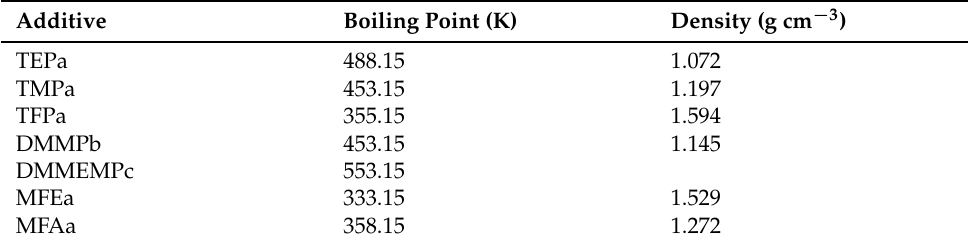
Table 17. Additive materials for electrolytes. Source from